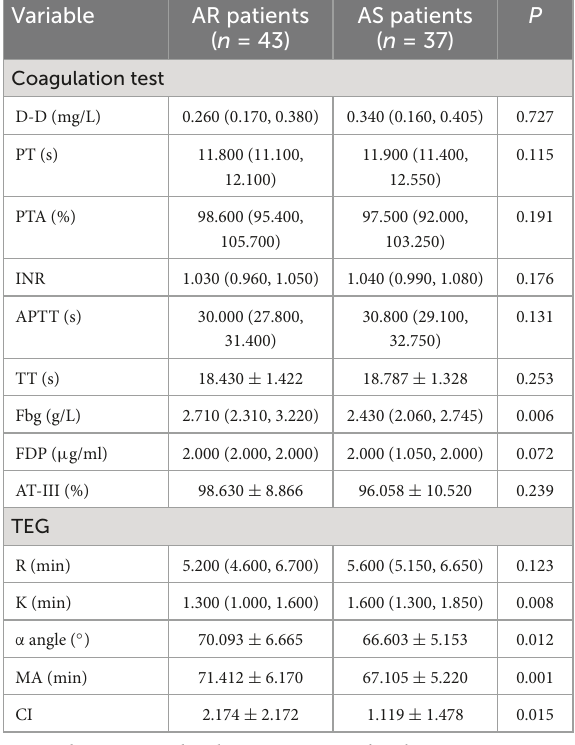
TABLE 1 Comparison of clinical characteristics between AR and AS patients.